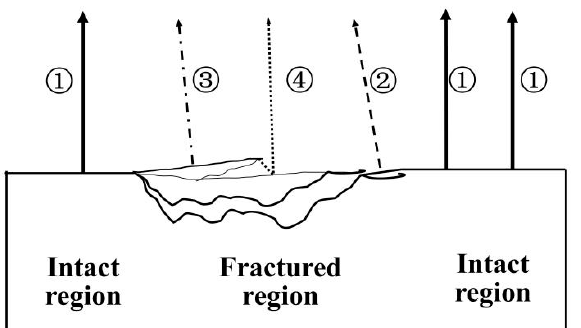
Figure 10. Schematic for the radiation transmission of local bulging.